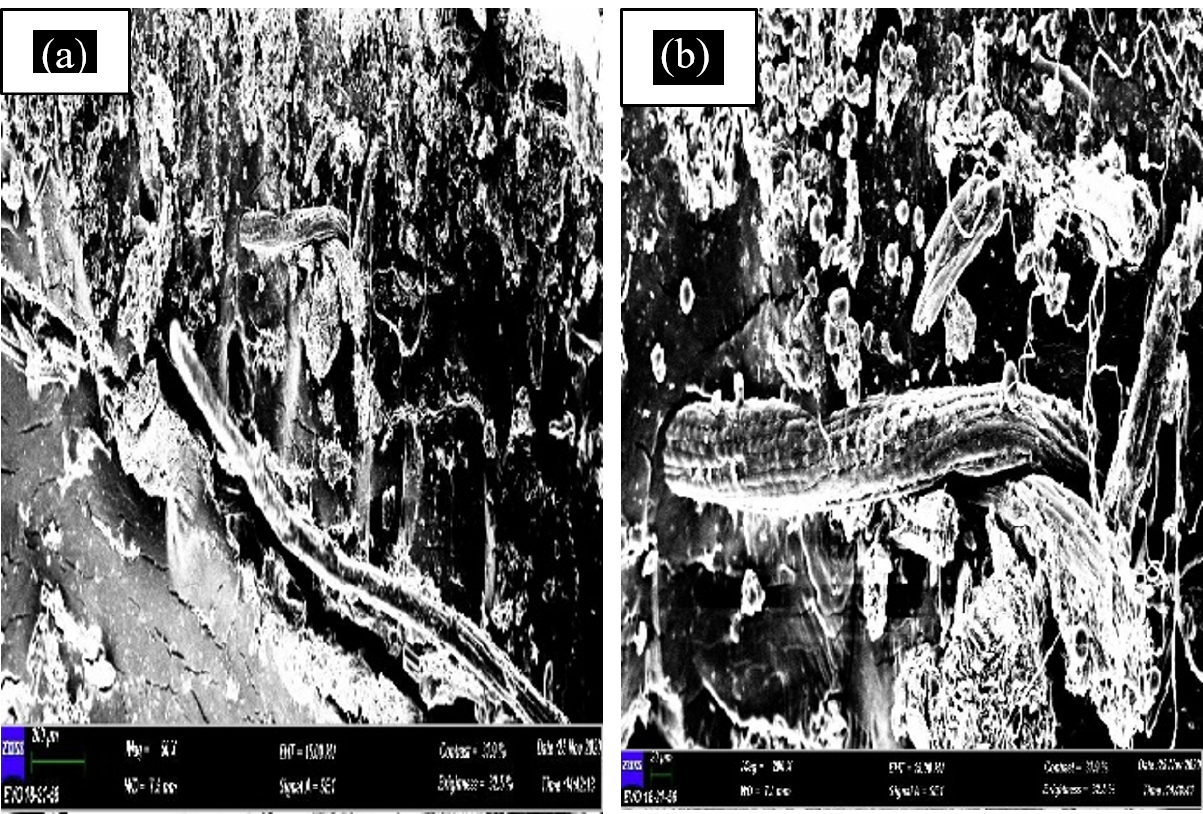
Figure 11. SEM micrograph of TPCS + 10 wt.% banana leaf fibre ( a ) and the breakage of the fibre can be observed more clearly, and a porous surface appeared ( b ).